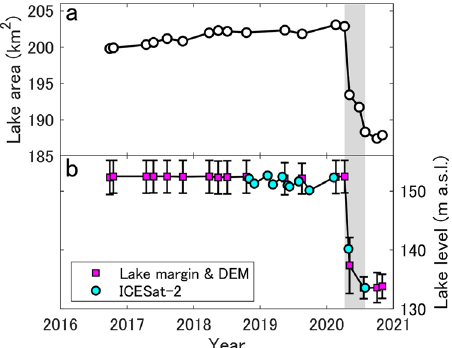
Fig. 2 Changes in lake area and water level of Lago Greve. a Area and b water level of Lago Greve from 28 September 2016 to 1st November 2020. Lake levels indicated by squares were measured by DEMs, while those indicated by circles were obtained by ICESat-2. Gray shaded area indicates the approximate period of the lake drainage event (from 9 April to 29 July 2020). Errorbars represent uncertainty of